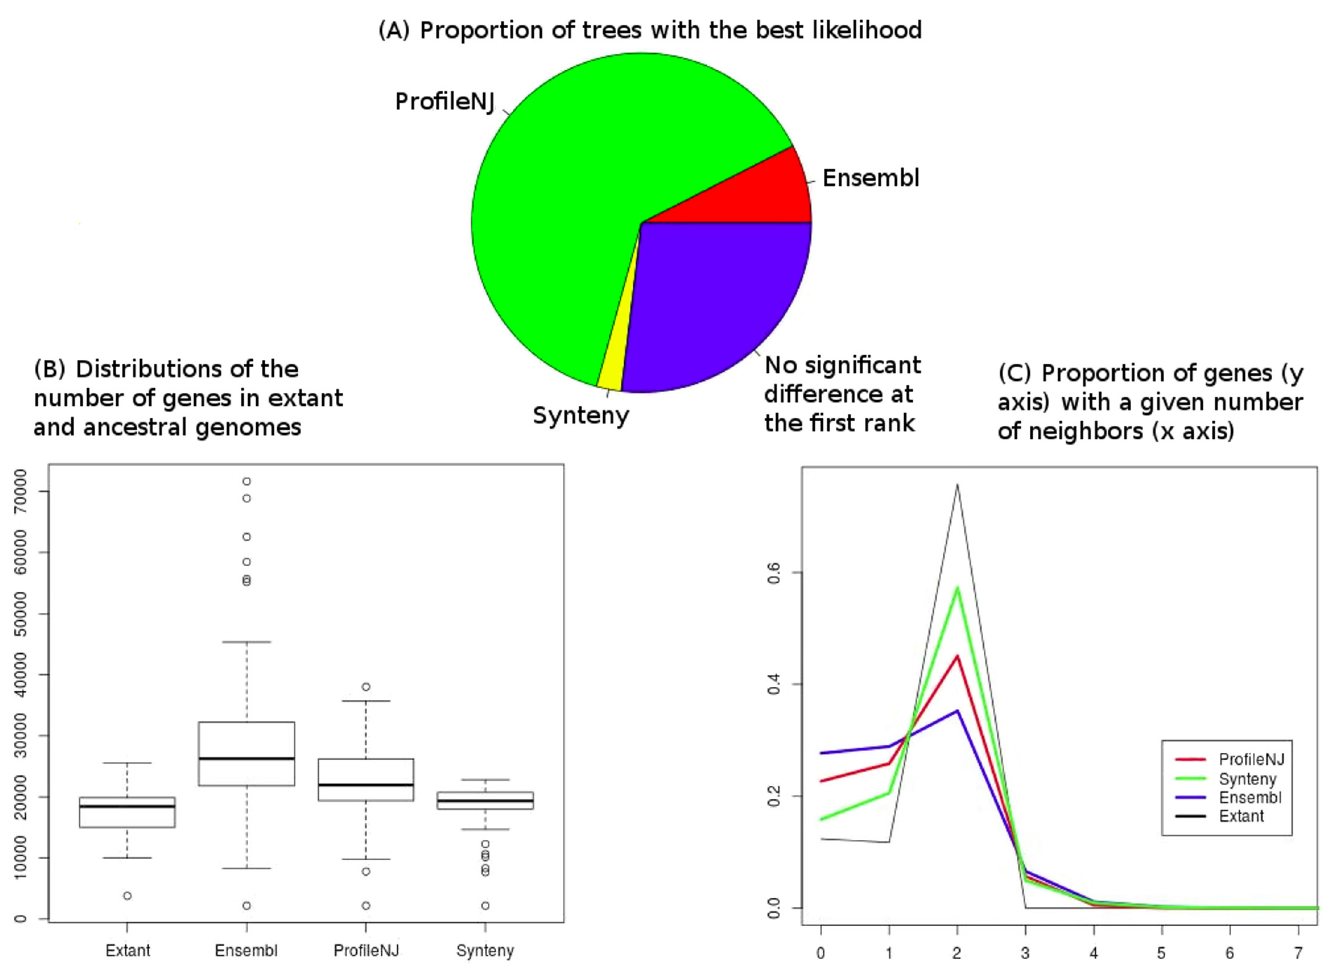
Fig 6. Sequence likelihood, ancestral genome content and ancestral chromosome linearity for ProfileNJ, Synteny and Ensembl trees. (A) Proportion of trees with a significantly better likelihood computed with PhyML. AU tests were computed for the three trees for each family, and if the tree at the first rank was significantly better than the second, it was stored as the best likelihood, and if not, it was stored as “ no significant difference at the first rank ” . (B) Gene content computed with DeCo. Gene content has one value for each node of the phylogeny of 63 species, except for extant genomes, for which it has one value for each leaf. (C) Genome linearity computed with DeCo. Genome linearity is represented by a graph, whose x axis is the number of neighbors a gene can have, and the y axis shows the proportion of genes having this number of neighbors. Parameters from extant genomes are given as a reference in (B) and (C). Statistics for ancestral genomes are assumed better when close to the extant